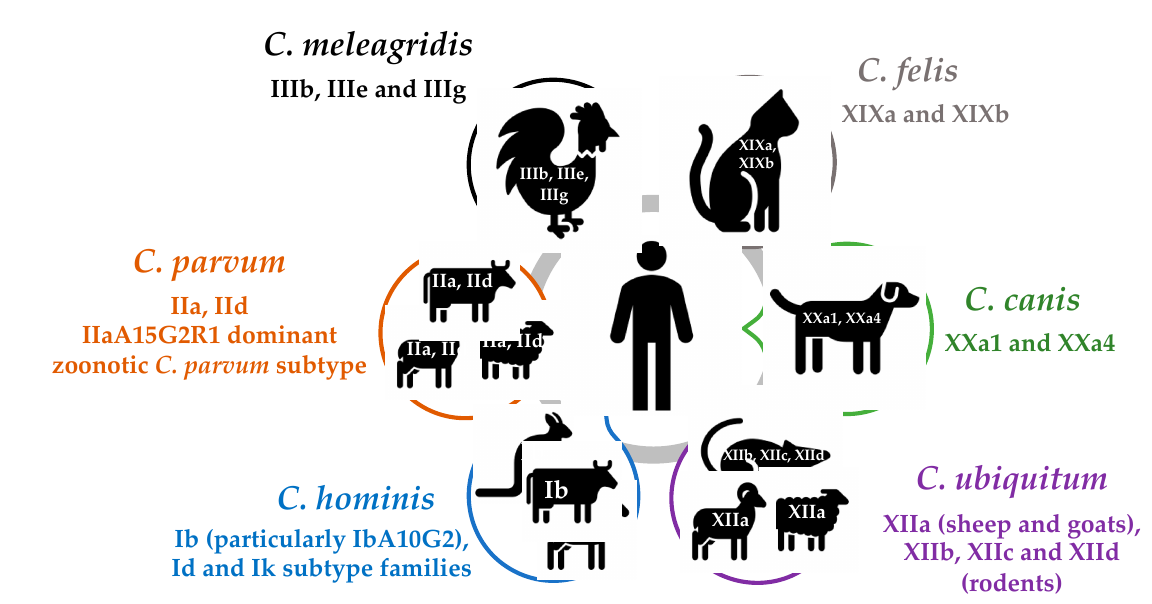
Figure 1. Zoonotic transmission of the six most common species of Cryptosporidium in humans.